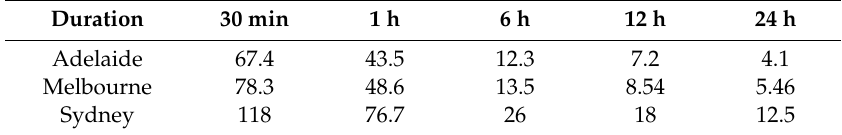
Table 3. Design Rainfall Intensity (mm / h) for the 1% annual exceedance probability (AEP) event. Duration 30 min 1